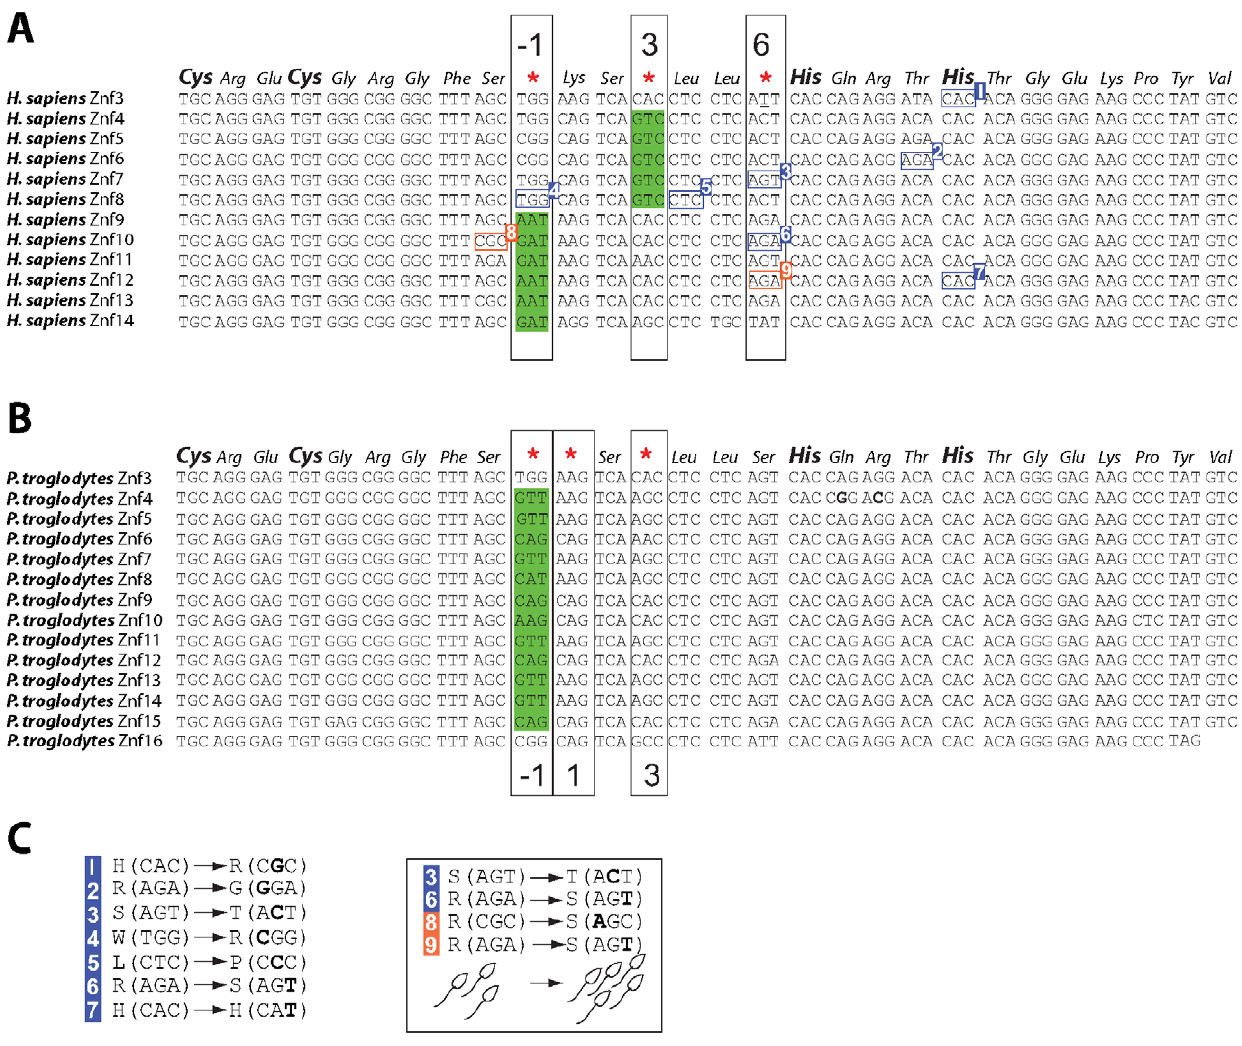
Figure 5. Sequence divergence and diversity among human and chimpanzee PRDM9 zinc finger sequences. (A) Multiple sequence alignment of human ( Homo sapiens ) PRDM9 zinc finger sequences, with positively selected positions ( P , 0.05, after multiple testing correction) indicated by red asterisks interspersed among a consensus amino acid sequence. Positions 2 1, 3, and 6 (numbered relative to the start of the zinc finger a –helix) that represent sequence-variable positions frequently involved in DNA binding are also indicated. Codons highlighted in green are not found at the same position in any chimpanzee PRDM9 zinc finger. (B) Multiple sequence alignment of chimpanzee ( Pan troglodytes ) PRDM9 zinc finger sequences with a predicted positively selected site indicated as in panel (A). Note that several chimpanzee PRDM9 zinc finger codons (highlighted in green) at positions 2 1 and 3 are unique to this species, relative to humans (A). (C) Numbered and boxed codons in panel (A) contain human nonsynonymous SNPs. SNPs numbered 1–7 were identified in this study among 50 Chinese individuals whilst heterozygous SNPs numbers 3, 6, 8,